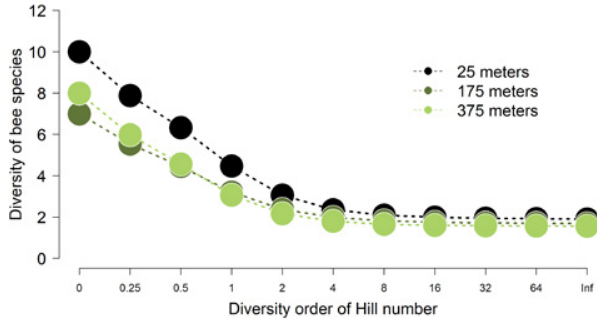
Fig 4 . Diversity profile of Hill number: bee diversity based on three distances from forest fragments on canola ( Brassica napus ) crops in Southern Brazil. For moving x-axis to left the rare species become more important, while to opposite side (right) there is more weight to equability of bee species. Some diversity indexes can be extracted from x-axis as: a) 0 = species richness; b) Shannon index; c) Simpson index; inf = Berger-Parker index.